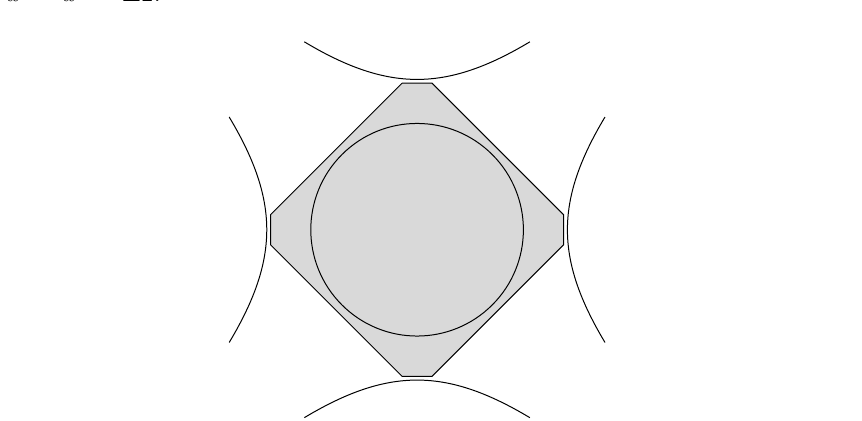
Figure 4 . The square 2 R that attains a sharp bound, together with the unit circle and the hyperbolas x 2 − ¯ x 2 = ± 2 .